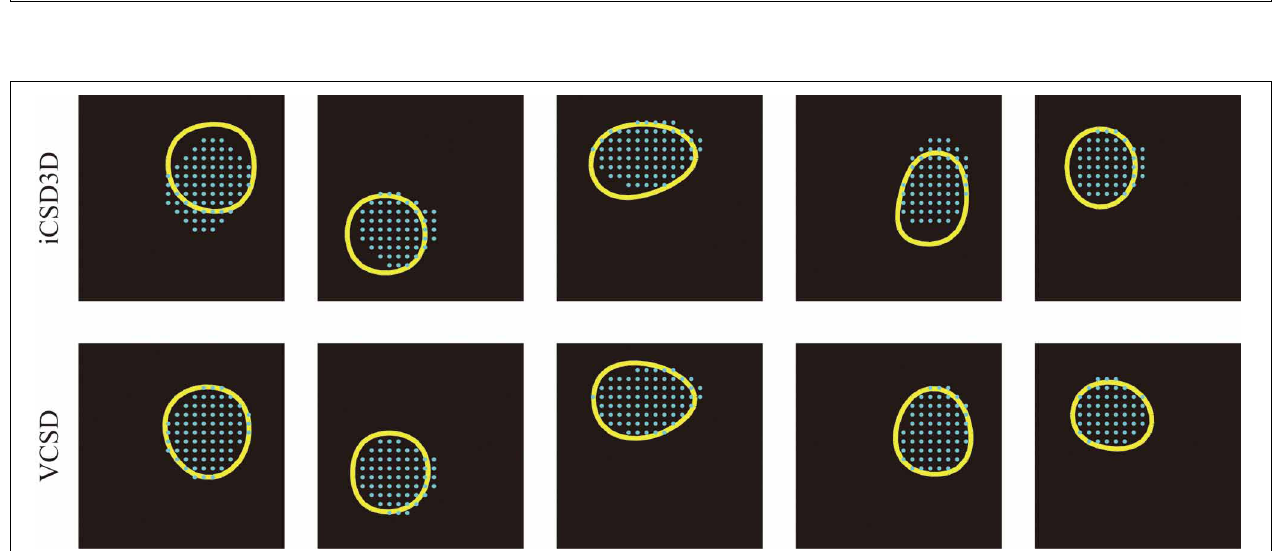
distribution at the depth of layer 4 and the anatomical barrel denoted by cyan dots. (D) The functional barrel (yellow circle) obtained from the xy -slice of the CSD distribution and the anatomical barrels. (E) Localization errors between the anatomical barrels and the corresponding functional barrels estimated by iCSD3D and vCSD methods. The one-tailed Mann-Whitney U Test ( P = 0.004, n = 5) was used to compare the performances of these two methods.